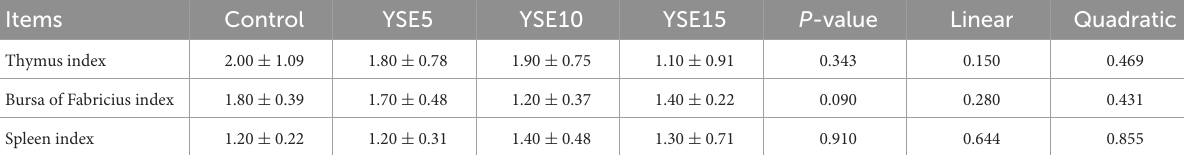
TABLE 3 Effects of supplemental different levels of YSE on immune organ index of young pigeons (g/kg) a . Items Control YSE5 YSE10 YSE15 P -value Linear